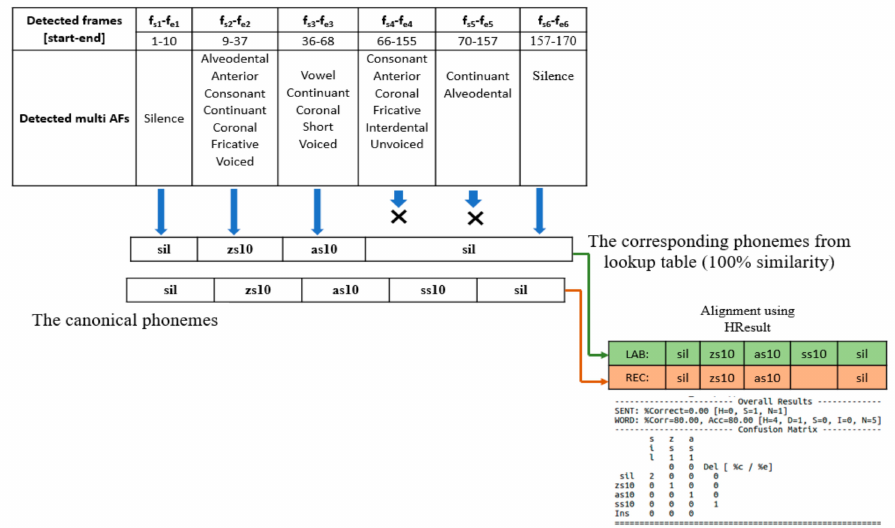
Figure 10. Testing example of converting the detected AFs using the YOLOv3-tiny-1S model to the corresponding phonemes and calculating the percentage of correct phonemes using the HResults tool (file “CMSSSFA”) from the KAPD corpus test set. X sign means invalid output, which occurs when the minimum hamming distance is greater than threshold (threshold = zero in case of 100%